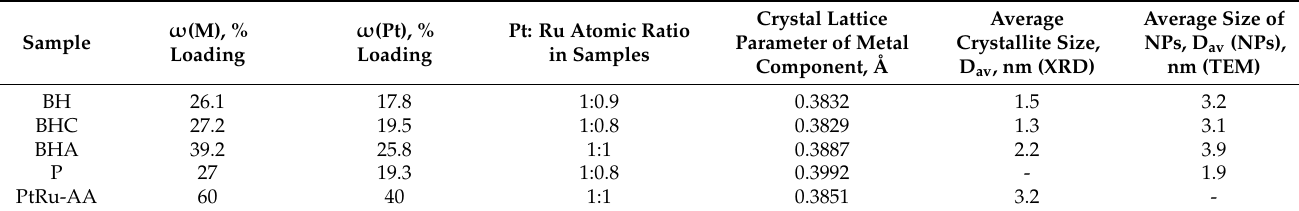
Table 1. The structural characteristics of the PtRu/C